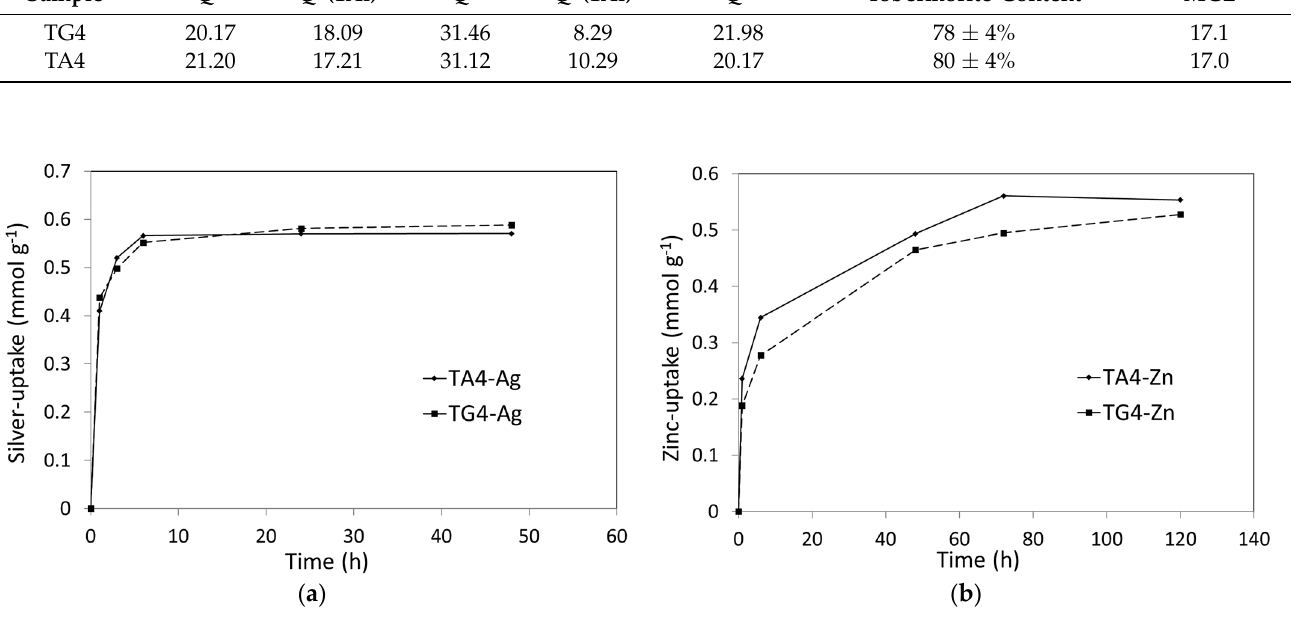
Figure 5. Uptakes of ( a ) Ag + ions and ( b ) Zn 2+ ions by tobermorite products TG4 and TA4. XRD analysis of the Ag + - and Zn 2+ -loaded samples, TG4-Ag and TG4-Zn (Figure 1), and TA4-Ag and TA4-Zn (Figure 2), indicated that the integrity of the tobermorite